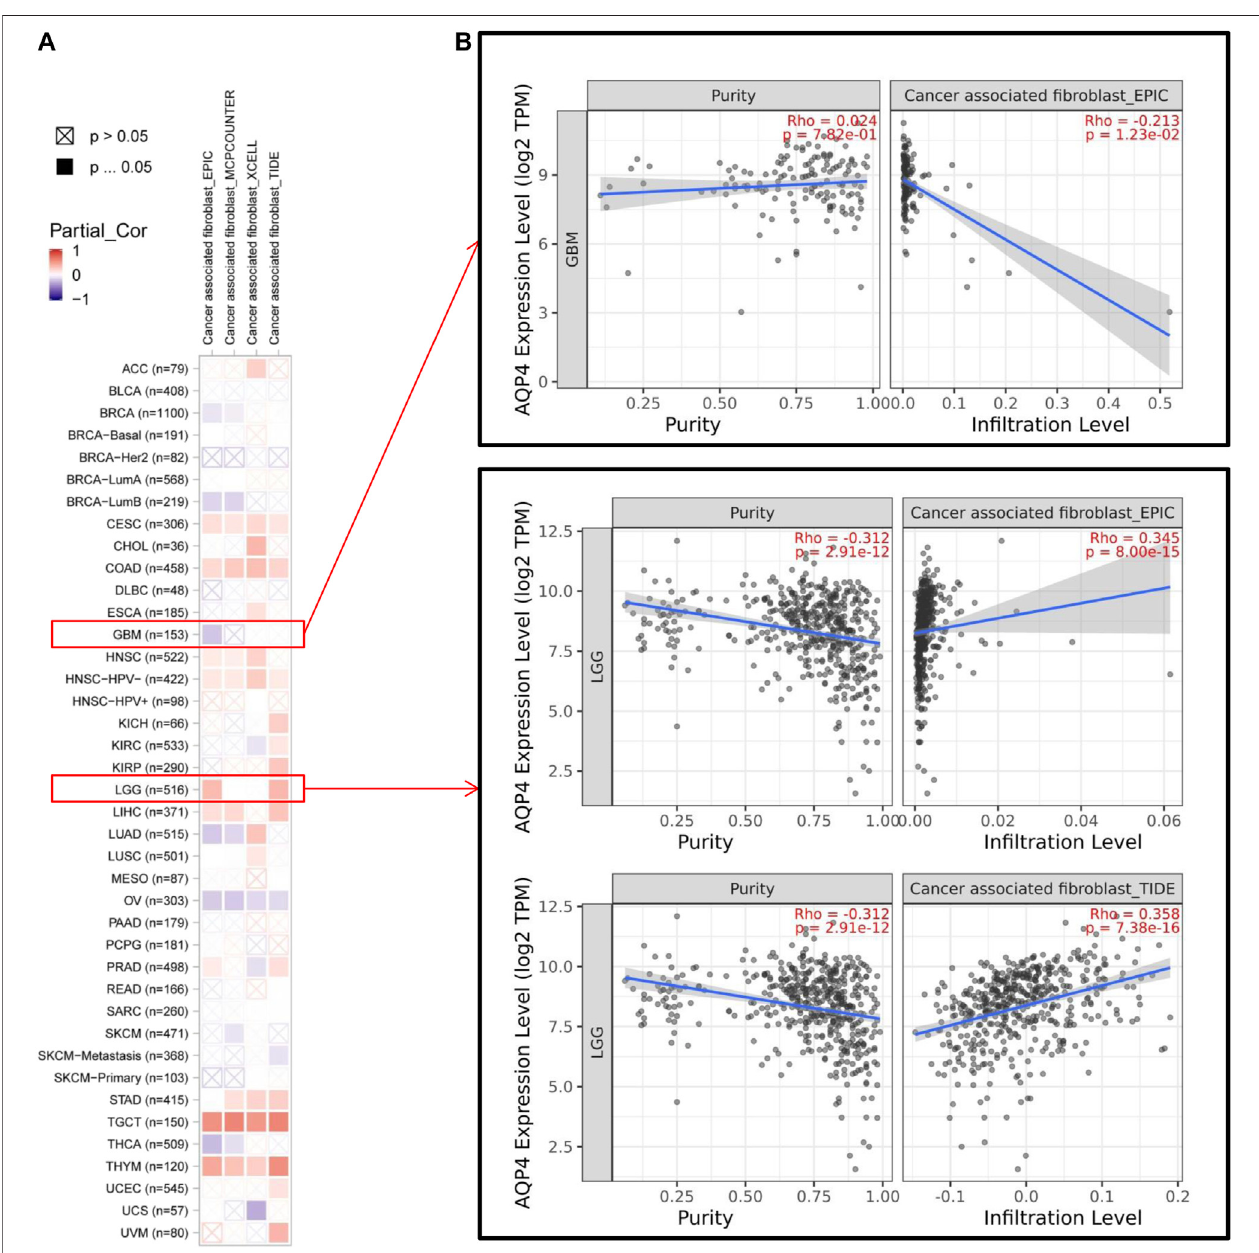
FIGURE4| ThecorrelationanalysisbetweenAQP4expressionandtumorcellin fi ltrationofcancer-associated fi broblastswasperformedusingdifferentalgorithms across various types of cancer information from the TCGA database.